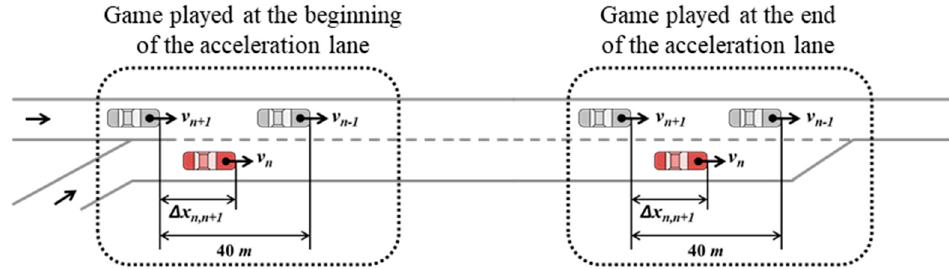
Figure 8. Topology of freeway merging section for sensitivity analysis.